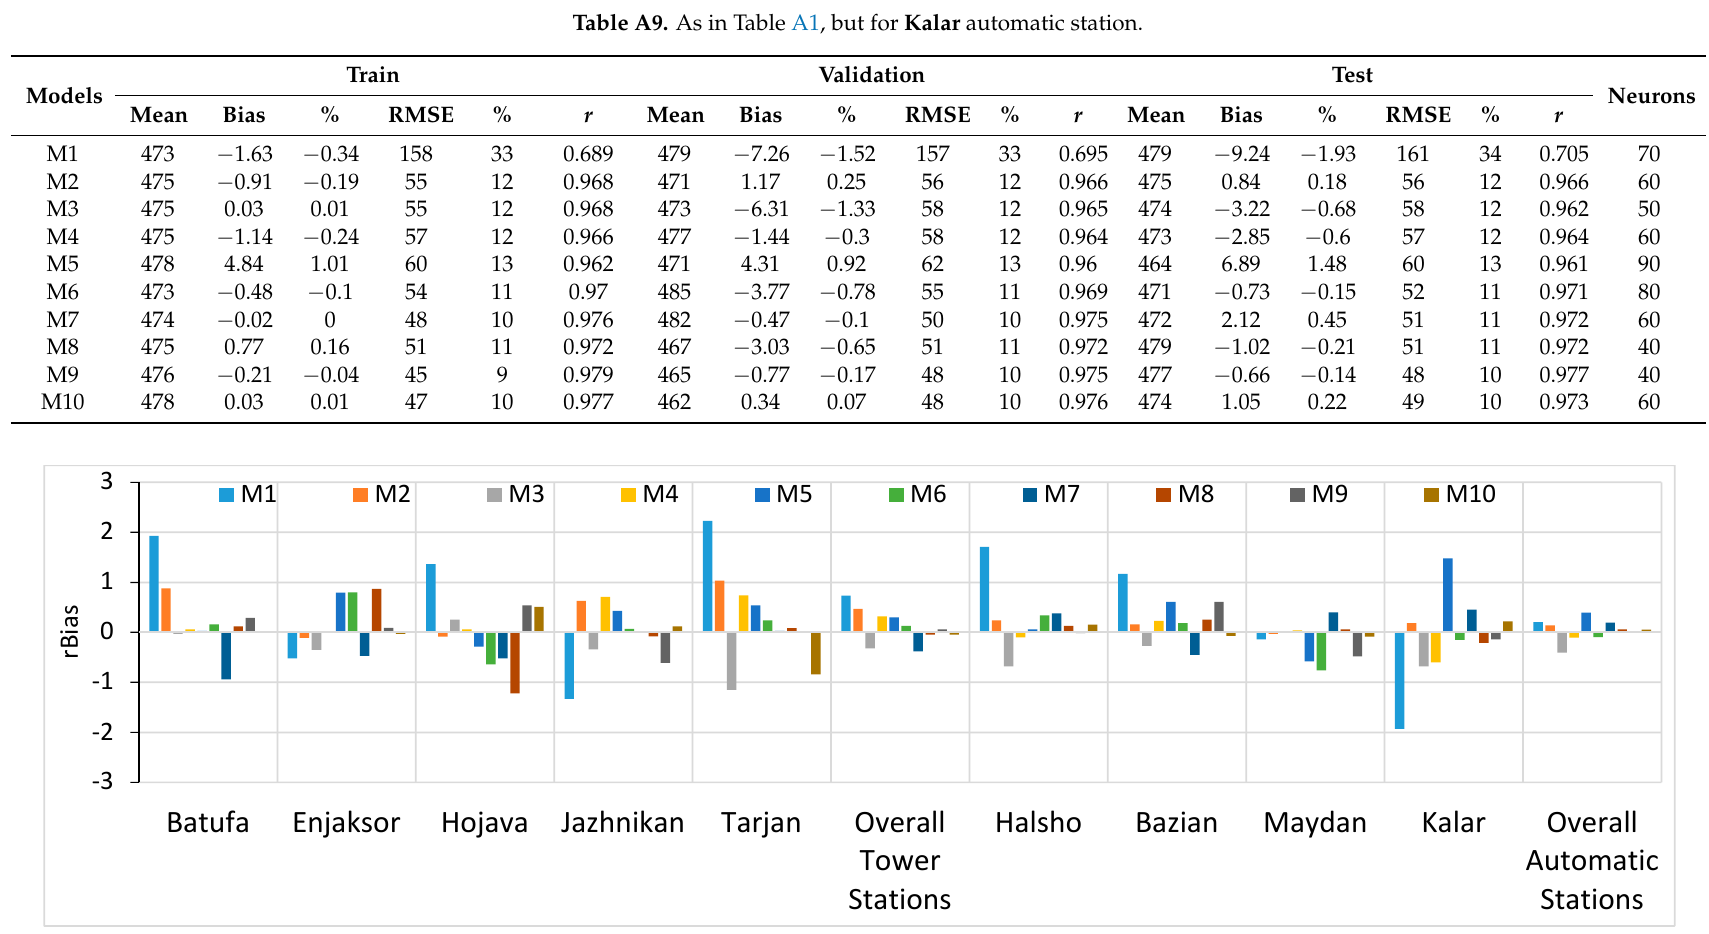
Figure A1. Comparison of rBias for the hourly GHI among models, stations, and overall results of station types.